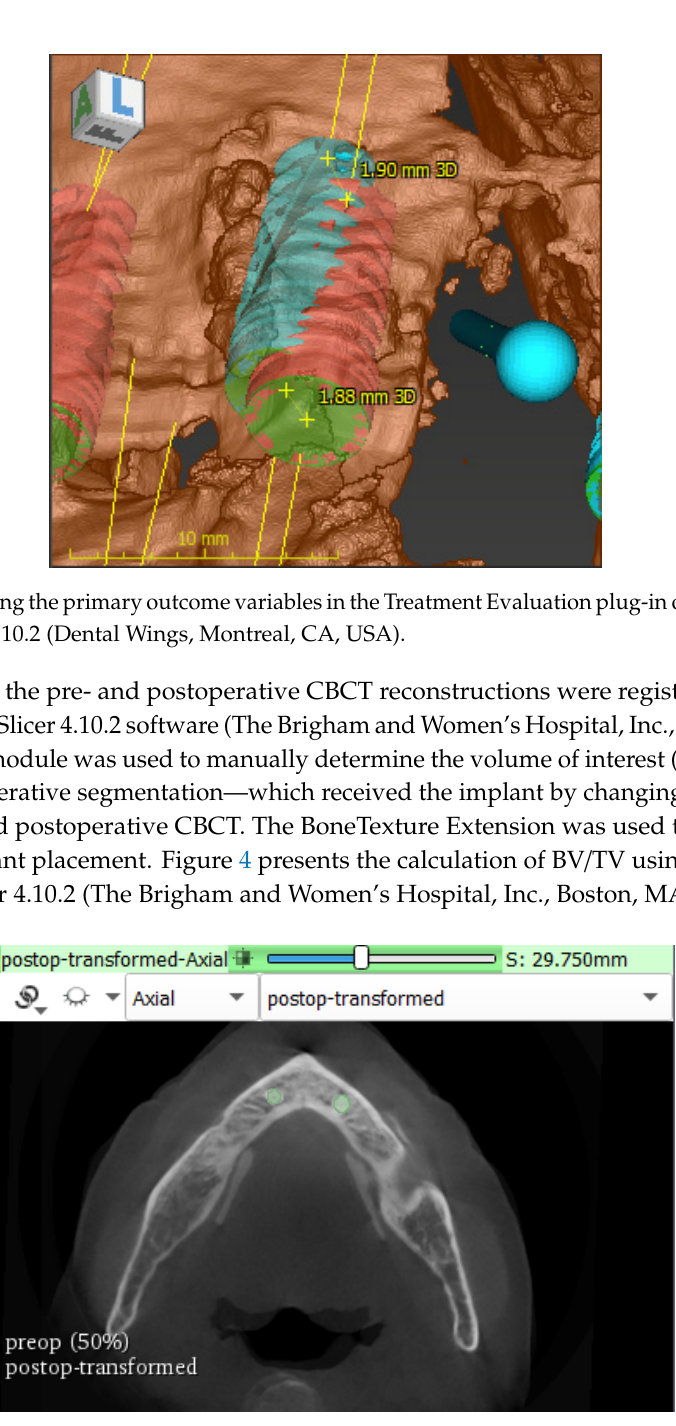
Figure 4. The calculation of the bone volume fraction (BV/TV) using the BoneTexture Extension of